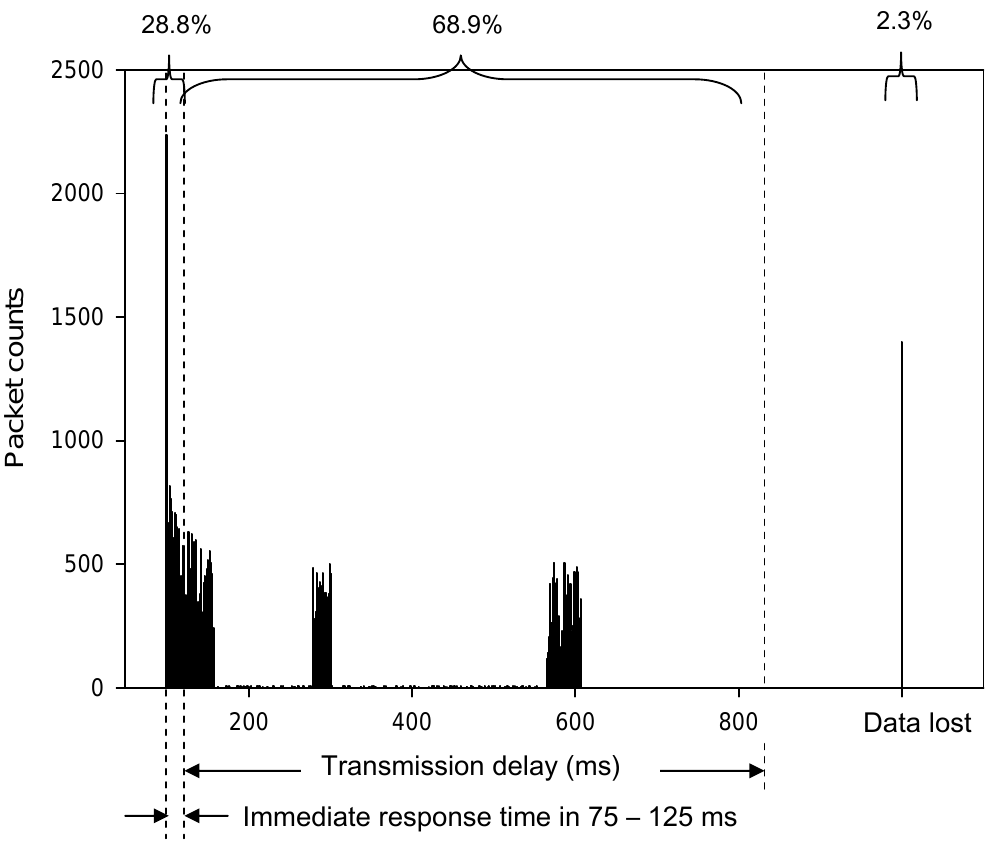
Figure 8. The number of packets delivered within the data acquisition response time, delayed counts, and lost counts recorded from a case study of the energy harvesting sensor network deployed in a convenience